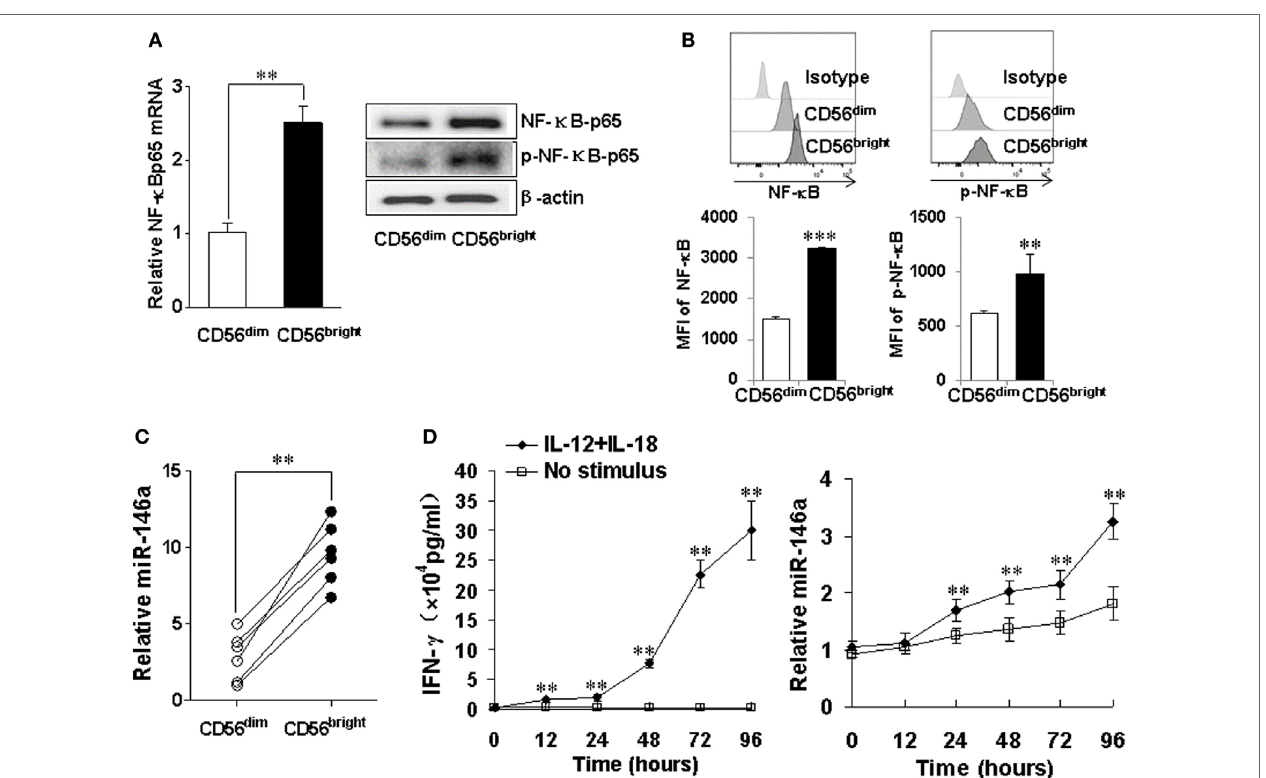
FigUre 7 | miR-146a and NF- κ B expressions in natural killer (NK) cell subsets CD56 bright and CD56 dim NK cells were sorted by a FACS Aria II cell sorter based on CD56 cell surface density, followed by assessment of NF- κ B p65 mRNA and protein levels by qRT-PCR and immunoblotting, respectively (a) . CD56 bright and CD56 dim NK cells were gated based on CD56 cell surface density and NF- κ B p65 protein levels and phosphorylation levels were assessed by flow cytometric analysis (B) . miR-146a expression was quantified by qRT-PCR in NK cell subsets (c) . CD56 bright NK cells were left unstimulated or co-stimulated with a combination of IL-12 (10 ng/ml) and IL-18 (100 ng/ml) for the indicated times, after which the supernatants were analyzed for IFN- γ production by enzyme-linked immunosorbent assay. Cell pellets were collected and used to prepare RNA and miR-146a expression and were quantified by qRT-PCR (D) . This experiment is representative of at least four such experiments performed with similar results. Data shown are mean ± SD. * p < 0.05; ** p < 0.01. Error bars represent